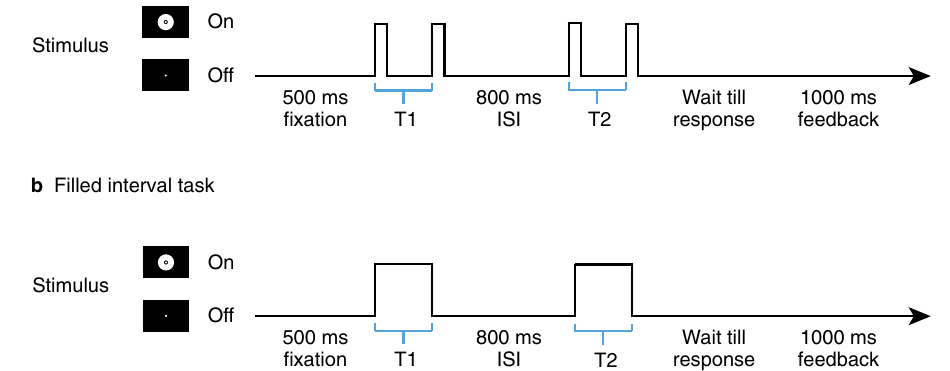
Figure 2. The duration discrimination task for empty ( a ) and filled ( b ) intervals. T1 and T2 represent two sequentially presented intervals: a standard interval (T) and a comparison interval (T + Δt). The presentation order was randomised across trials. We followed the one-up-three-down staircase method, changing Δt according to the responses obtained in previous trials (see “Methods” for details). ISI: inter-stimulus interval.